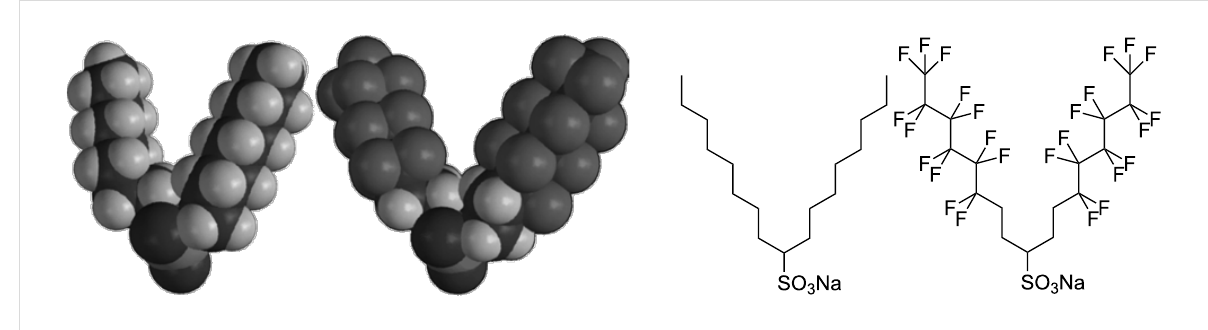
Figure 3: Structures illustrating the difference in fraction free volume (FFV) within a surfactant tail region through fluorination. On the left is a surfac- tant with a relatively high fractional free volume (DiH8) and on the right a surfactant with relatively low fractional free volume. The use of bulky fluorine atoms decreases the volume available to the solvent, hence reducing FFV value [78]. Reprinted with permission from [78]. Copyright 2004 American Chemical